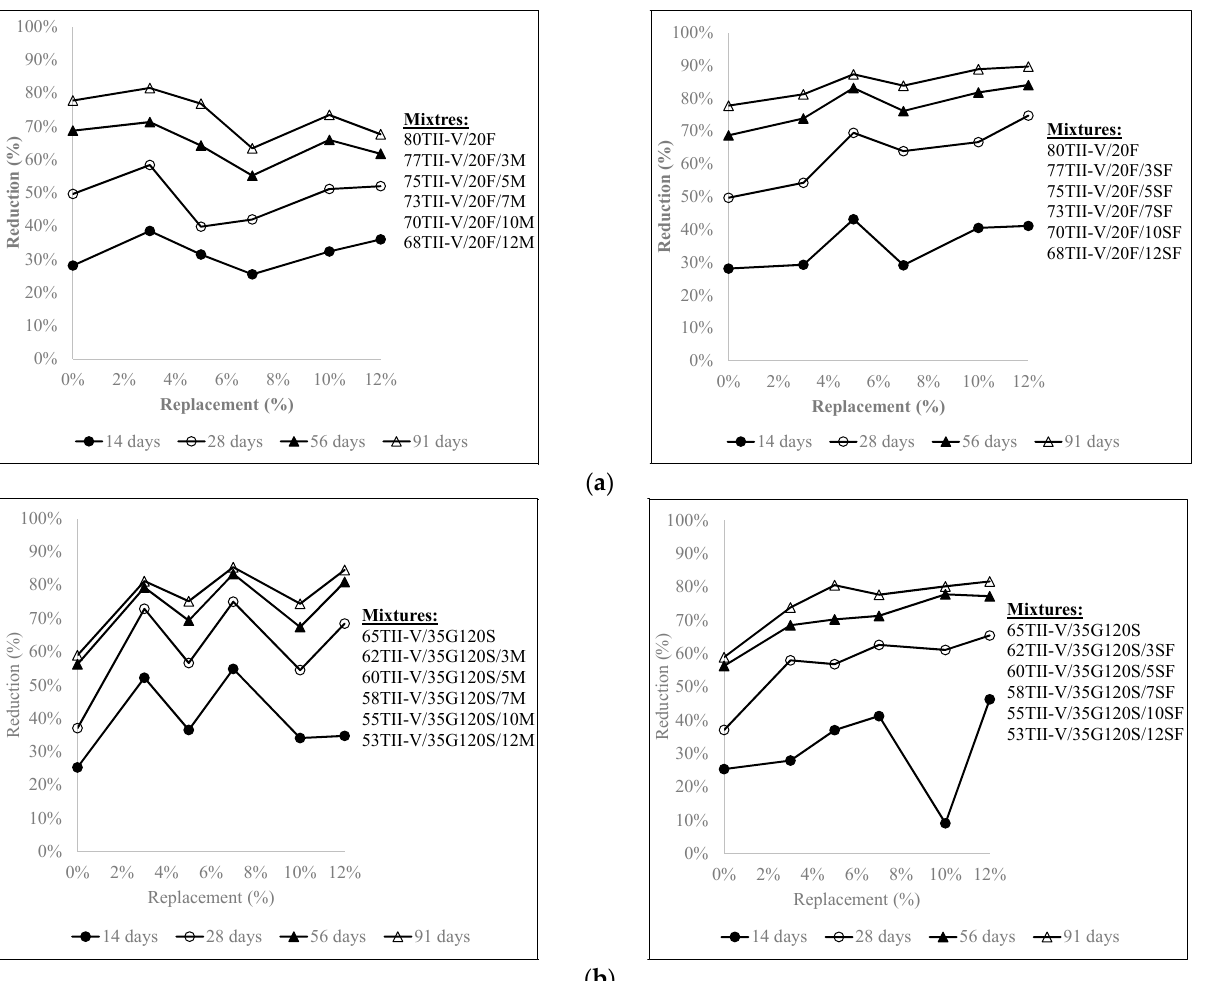
Figure 8. Influence of different replacements of silica fume and metakaolin in ( a ) 20% Class F and ( b ) 35% G120S mixtures.